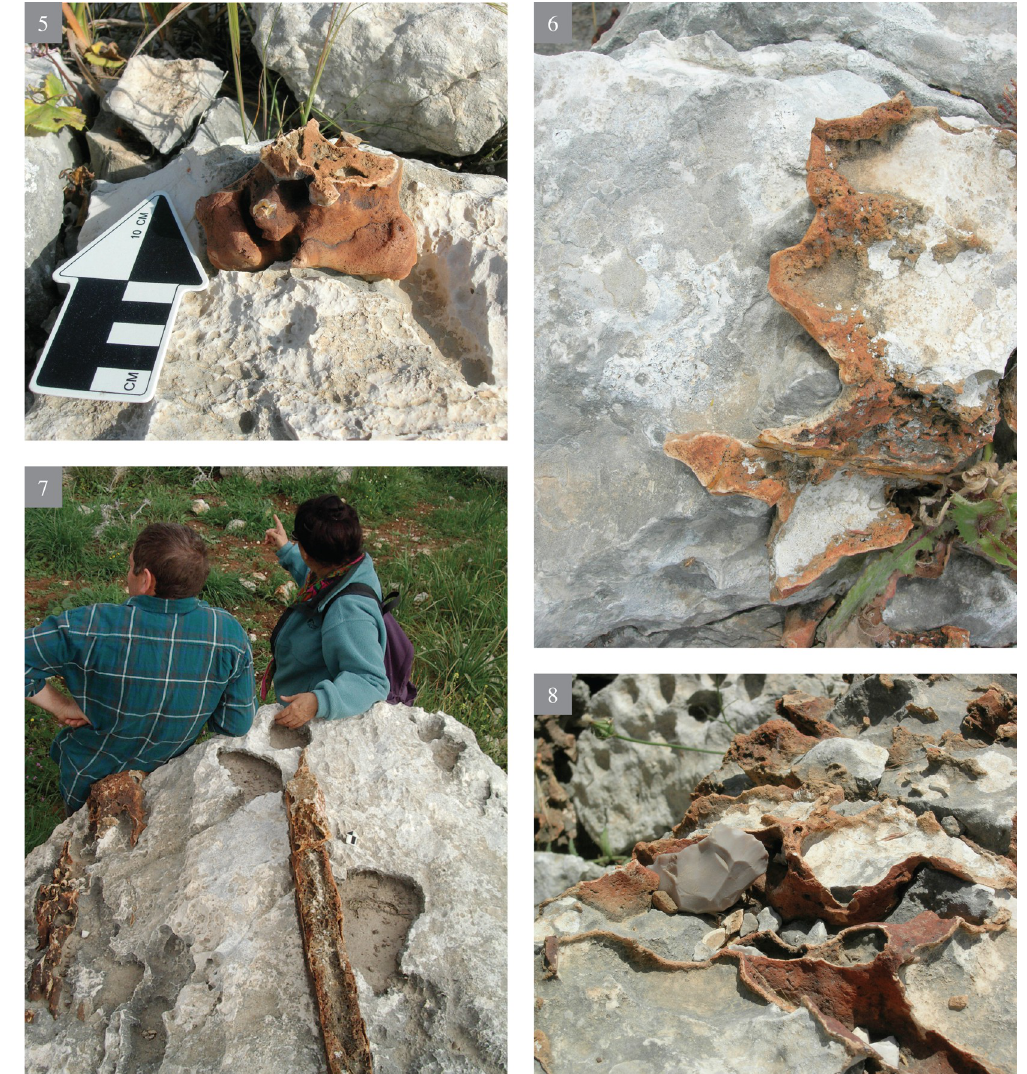
Fig 3. Bi’na formation—appearance and morphology